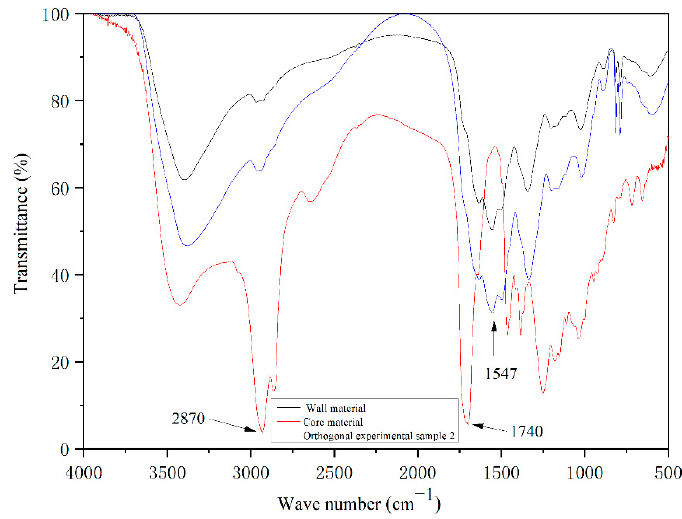
Figure 3. Infrared spectrum of wall material, core material, and microcapsule.